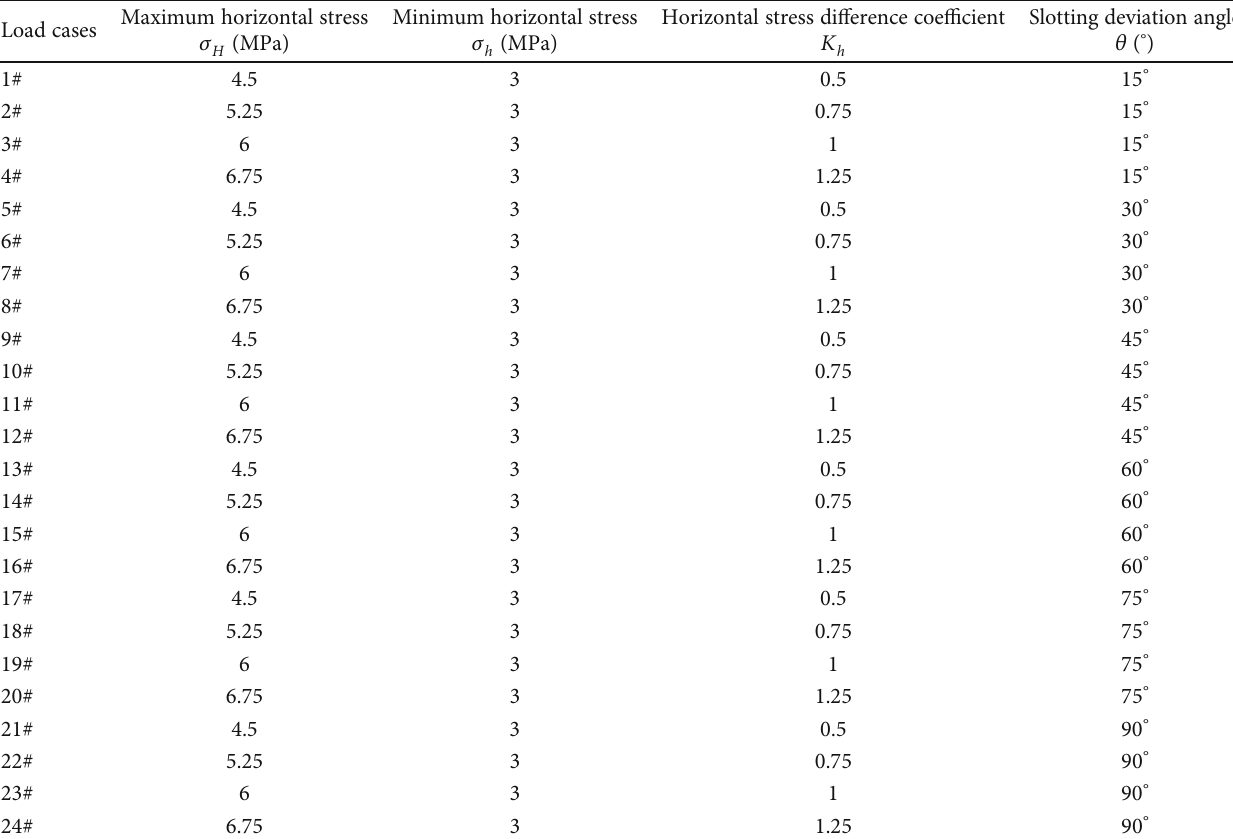
Table 2: Loading cases considered in the numerical